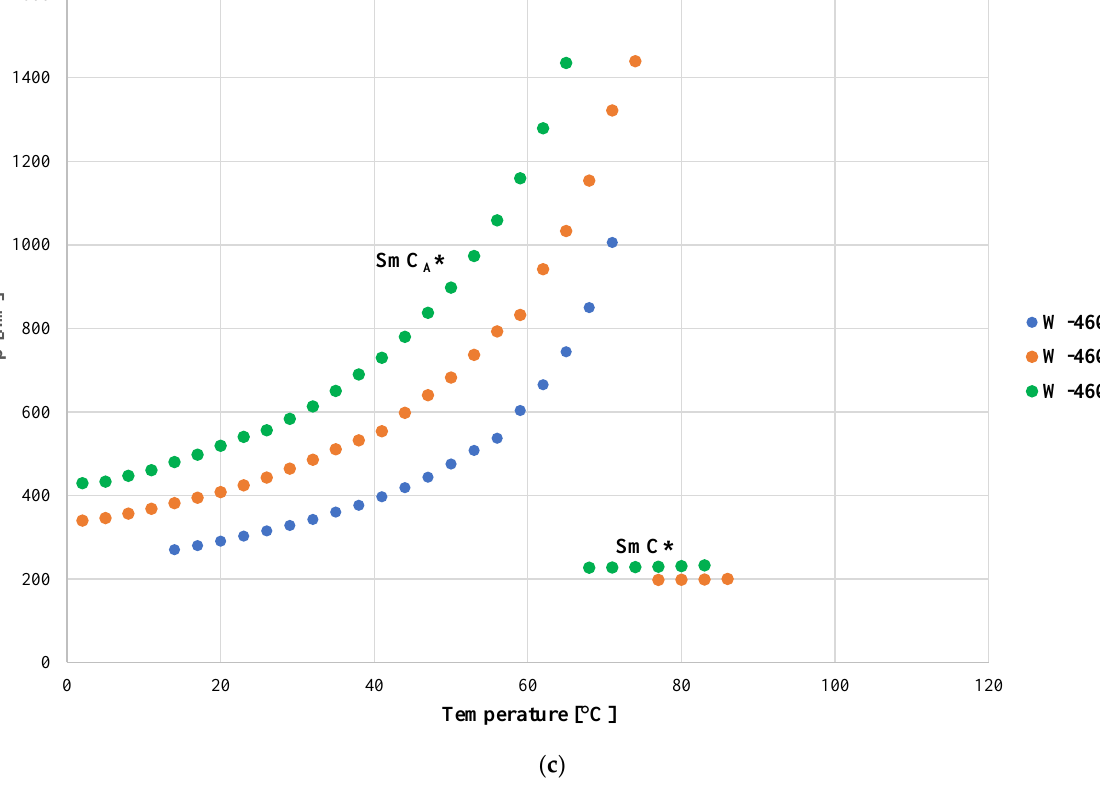
Figure 6. ( a ) The temperature dependence of the helical pitch for mixtures W-458 , W-458A and W-458B . ( b ) The temperature dependence of the helical pitch for mixtures W-459 , W-459A and W-459B . ( c ) The temperature dependence of the helical pitch for mixtures W-460 , W-460A and W-460B . (“*” means that the phase is observed).